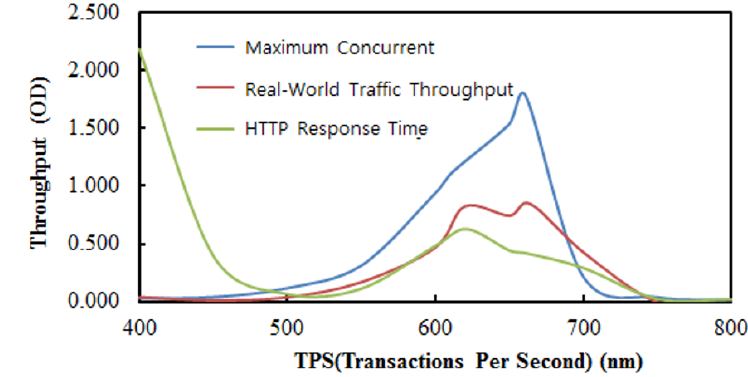
Figure 17. Default smart grid security performance.